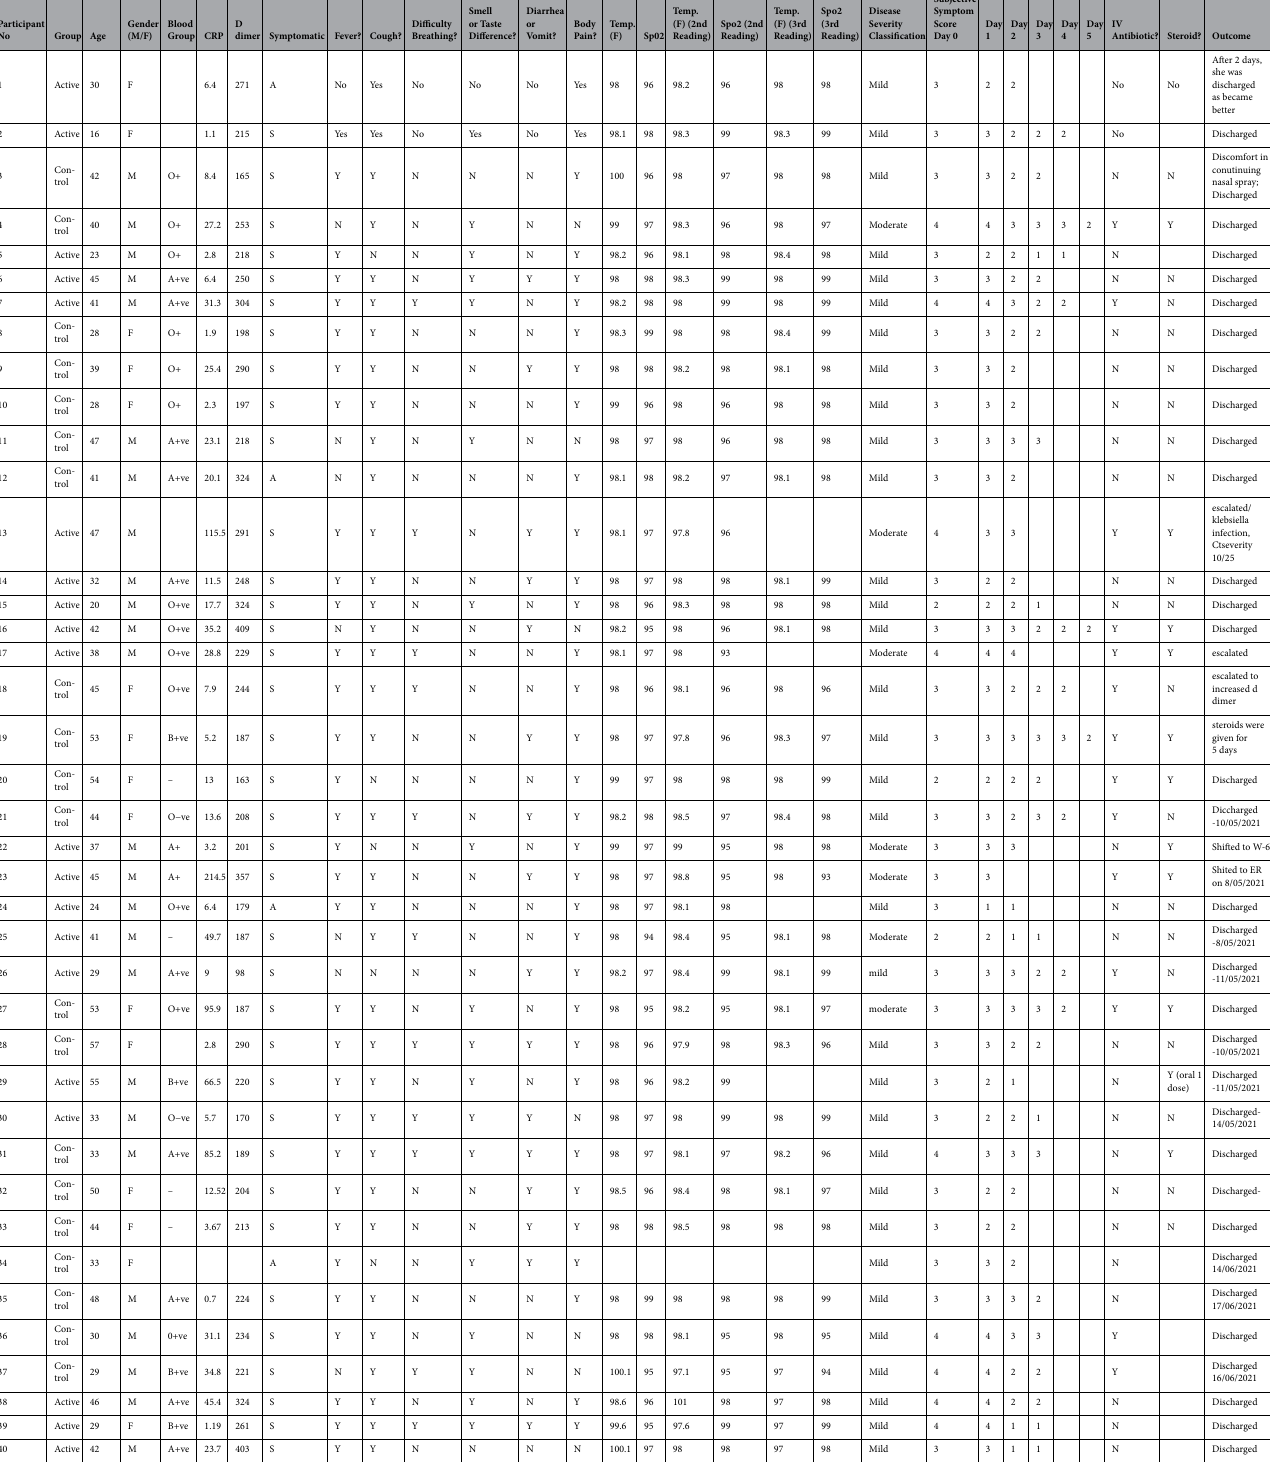
Table 1. Patient assessment data for the 40 COVID-19 positive human subjects in the randomized control study of daily nasal and upper airway administration of calcium-rich salts (FEND) at Bangalore Baptist Hospital. See Supplemental Material for X-Ray and exhaled aerosol